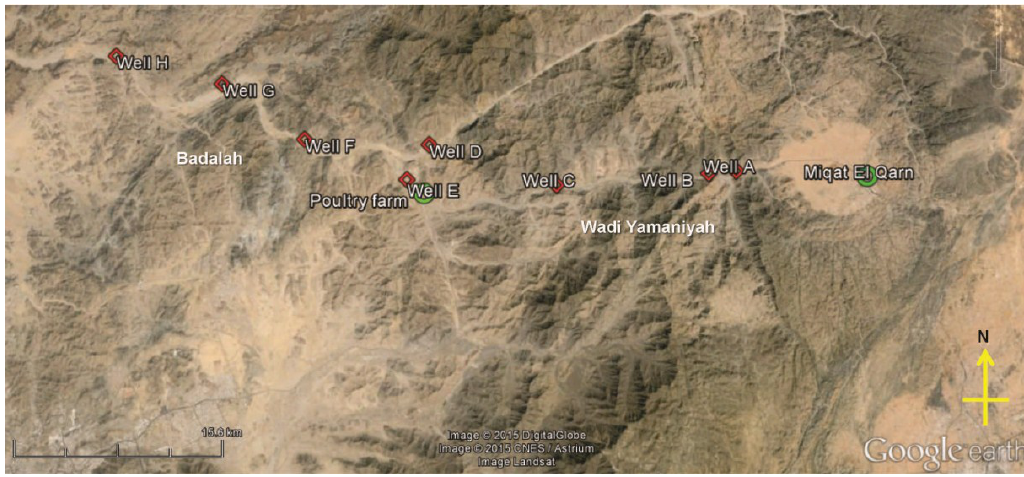
Figure 1. Sampling site in Taif, Saudi Arabia. Groundwater samples were collected from wells A through H. Groundwater direction flows from A to H. Tomatoes and green peppers irrigated with groundwater from wells B and F were sampled. Green circles denote potential sources of anthropogenic contamination. Miaqt E1 Qarn is a gathering venue for